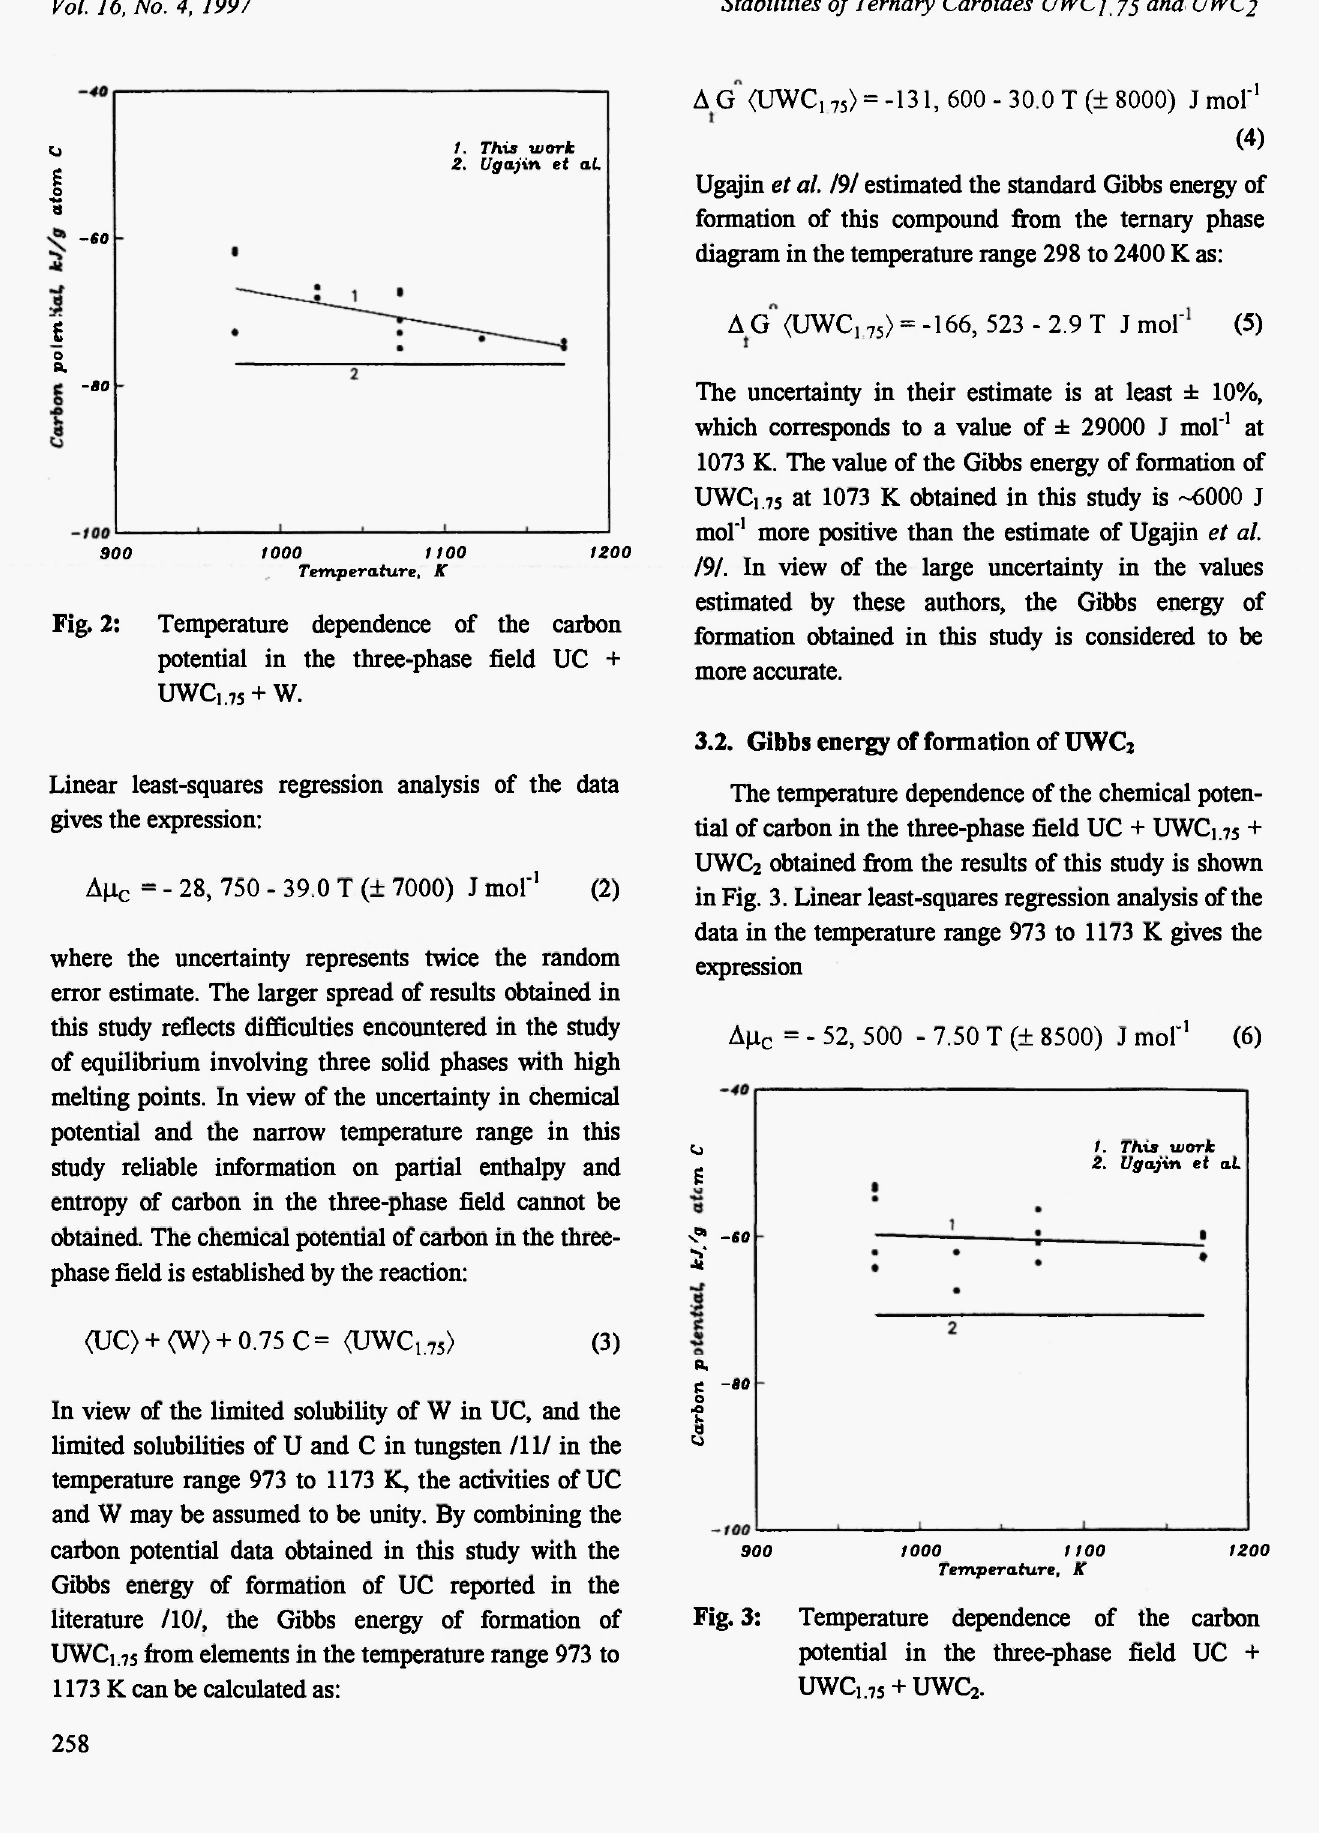
Fig. 2: Temperature dependence of the carbon potential in the three-phase field UC + UWC1.75 + W.